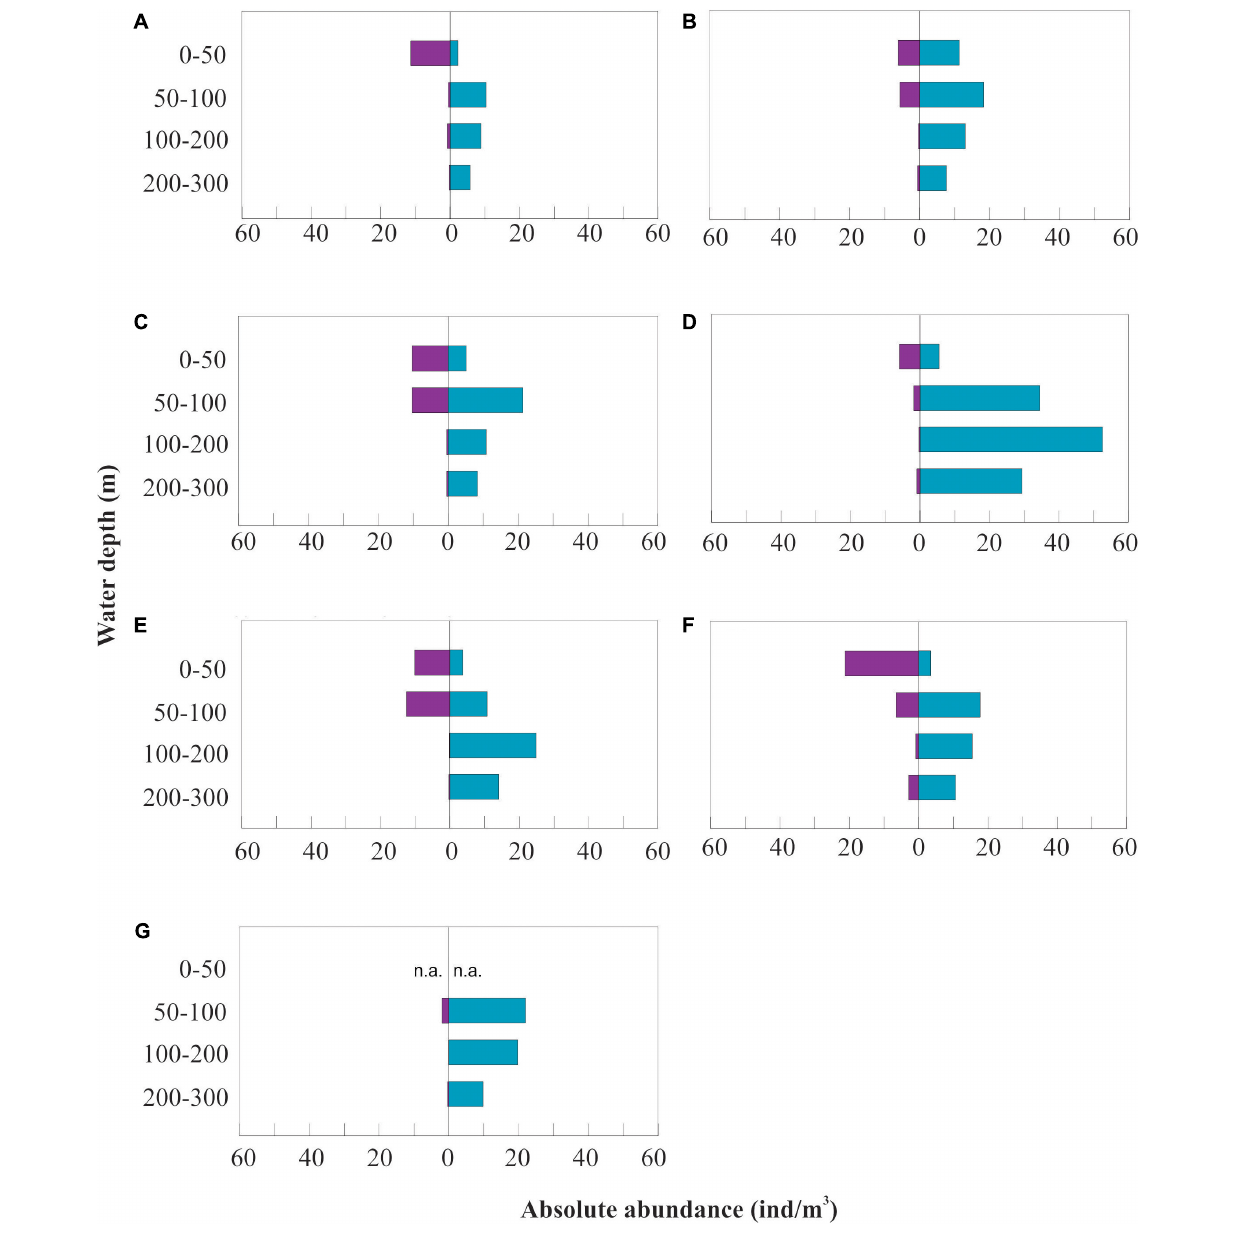
FIGURE 3 | Absolute abundance (ind m − 3 ) of planktic foraminifera (blue) and pteropods (purple) of stations 1–7 (A–G) along the water column (n.a., not